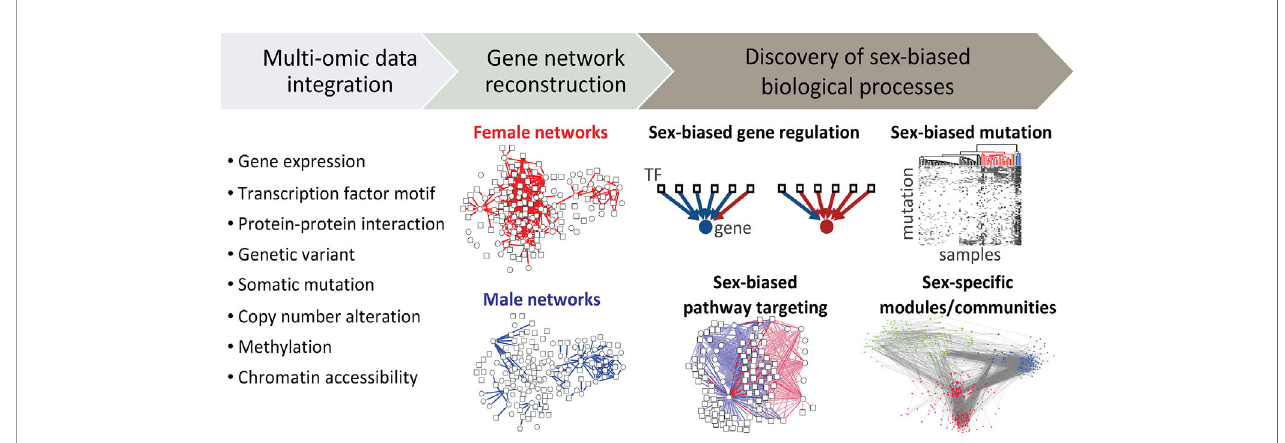
FIGURE 4 | Using systems-based approach to study sex differences. Multi-omic data can be integrated to reconstruct gene networks that combine sex- and gender-biased effects and map how the connectivity and activity of genes differ between males and females. Analyzing the network topology and changes in network structure of males and females can provide insights into molecular mechanisms involved with sex differences in cancer. TF, transcription